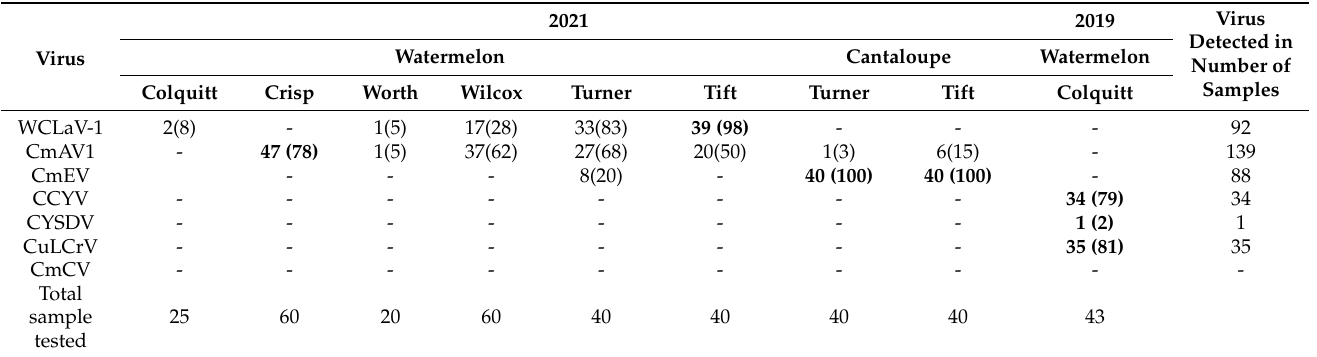
Table 3. Incidence and prevalence of viruses from fall 2019 and spring 2021 cantaloupe and water- melon samples in Georgia as detected by PCR and